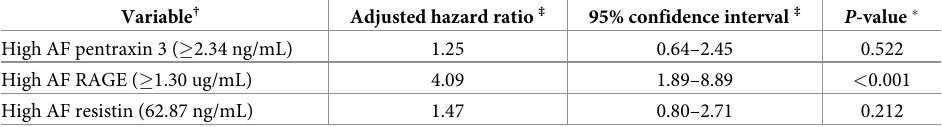
Table 5. Cox proportional hazard analysis of cerclage-to-delivery